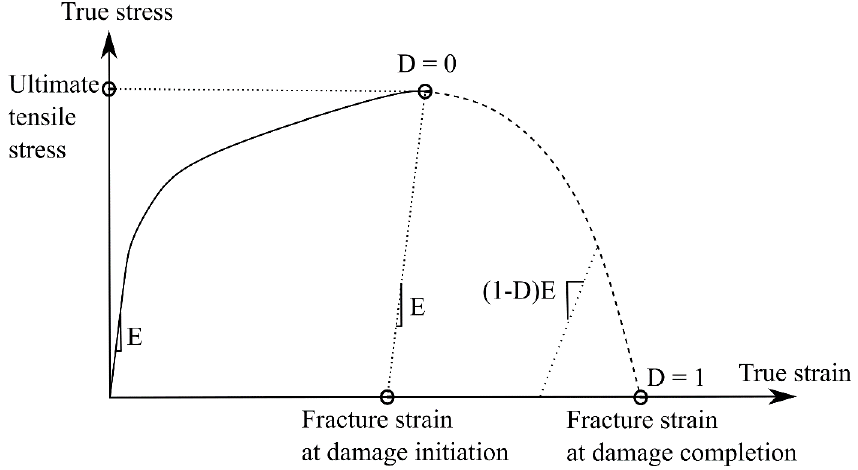
Figure 7. Typical stress – strain curve showing strain hardening and softening post damage initiation.